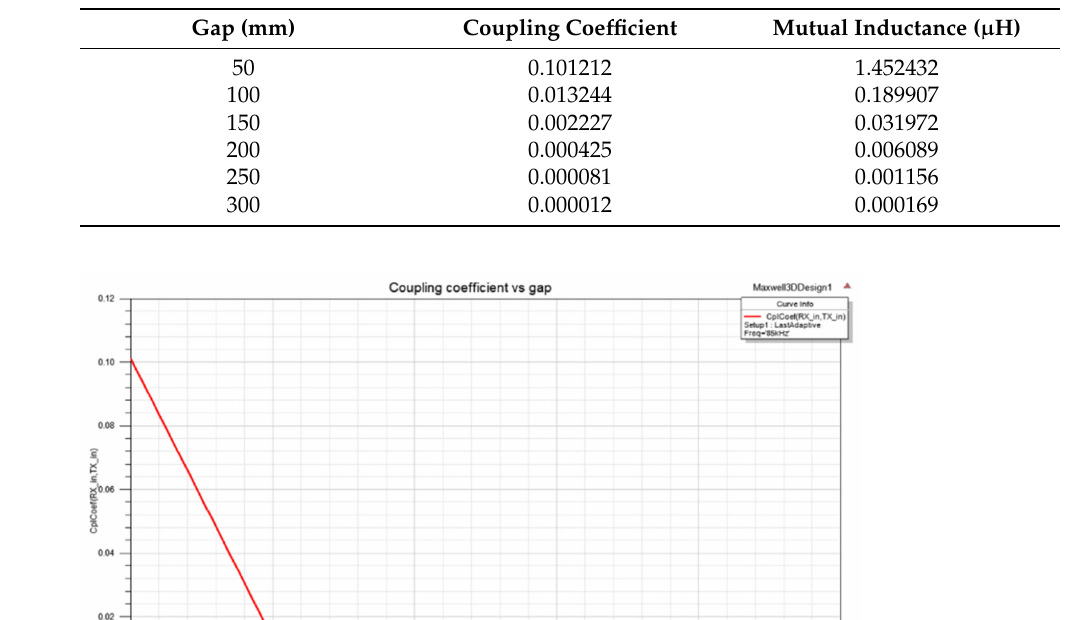
Table 3. Simulation results of rectangular coil model with ferrite.